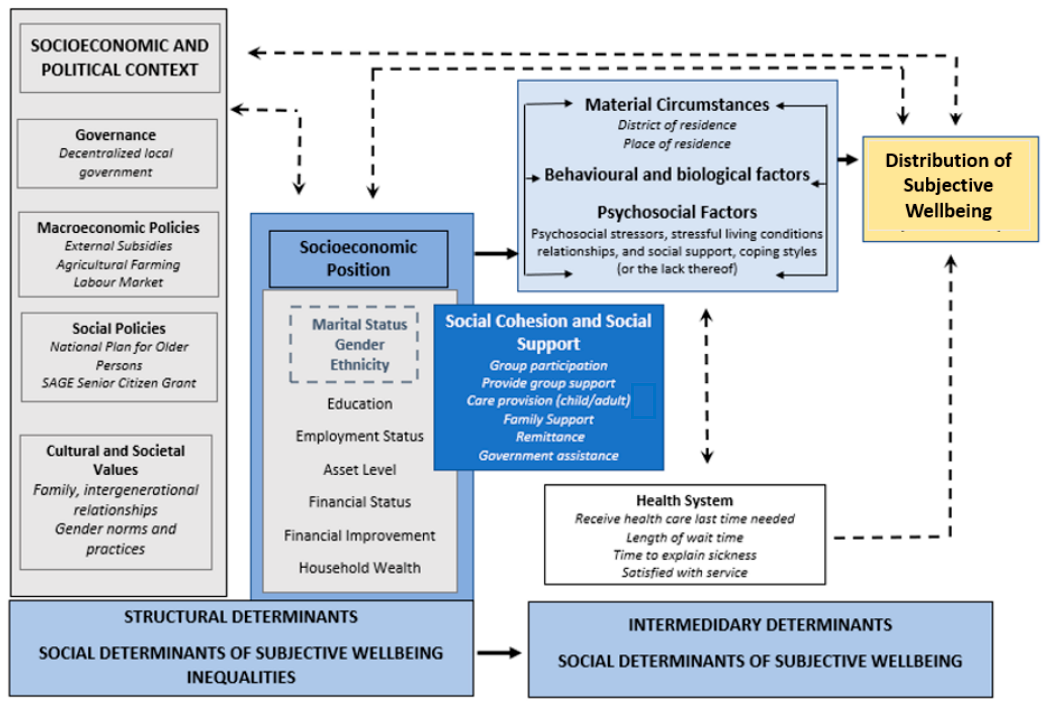
Figure 1. The Social Determinants of Elderly Subjective Wellbeing in the Central Region of Uganda. Adapted from the World Health Organization (WHO) Commission on Social Determinants of Health Framework [56].